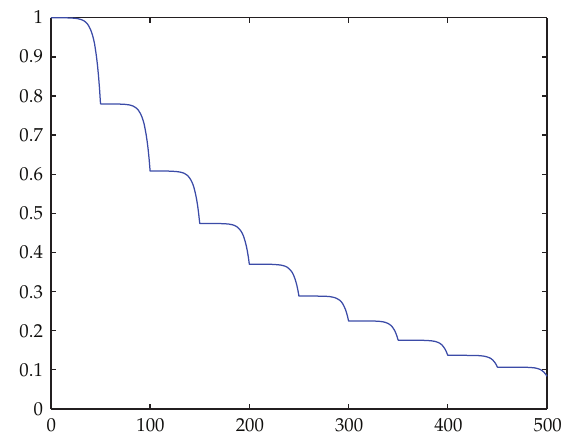
Figure 5: The Gauss collocation method with m (cid:4) 2 and p (cid:4) 50 for (cid:2) 7.2 (cid:3) .